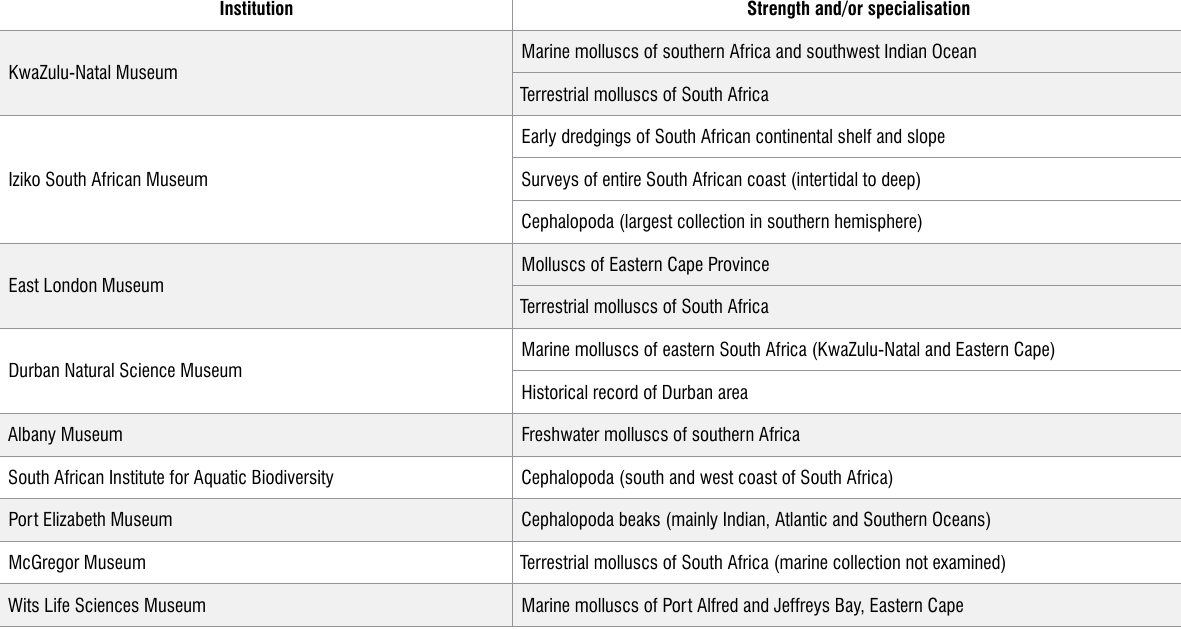
Taxon and regional specialisations of South African mollusc